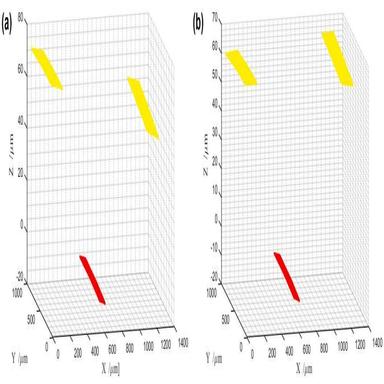
Data visualization of the evaluated planes in Experiment 1: (a) The evaluated planes; (b) The results after levelling the upper two yellow planes. (For interpretation of the references to color in this figure legend, the reader is referred to the Web version of this article.)